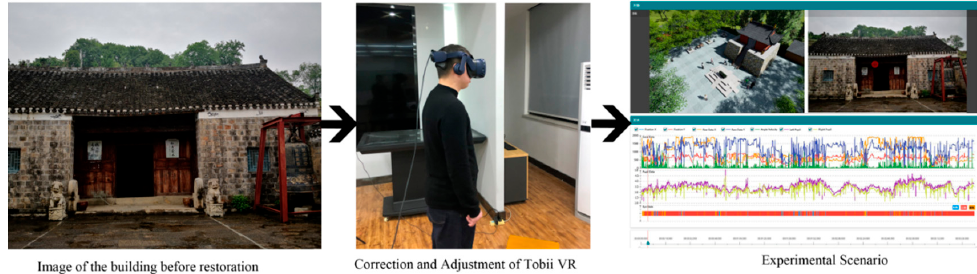
Figure 5. Experimental scenario of the ErgoLAB human-machine environment synchronization platform.